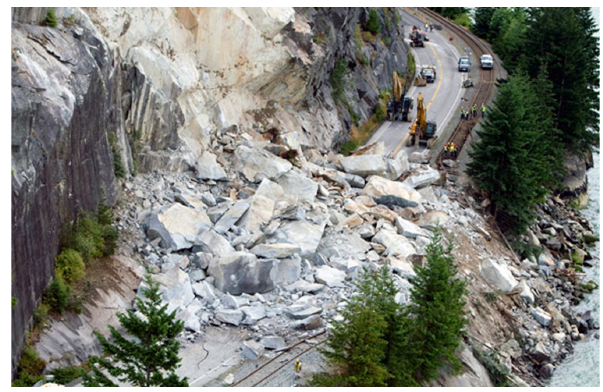
Fig. 1. Rockfall on Sea to Sky highway (B.C.). Note the jointed structure of the source area (Canadian Press